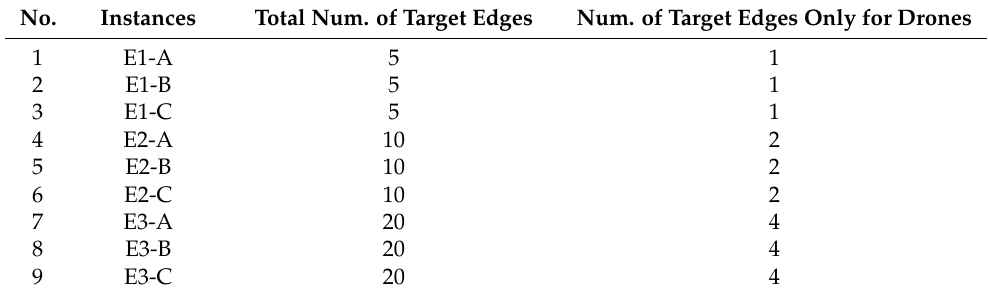
Table 4. Introduction of the